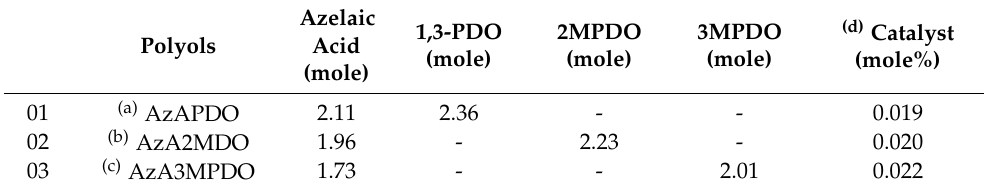
Table 1. Polyester polyol formulations.